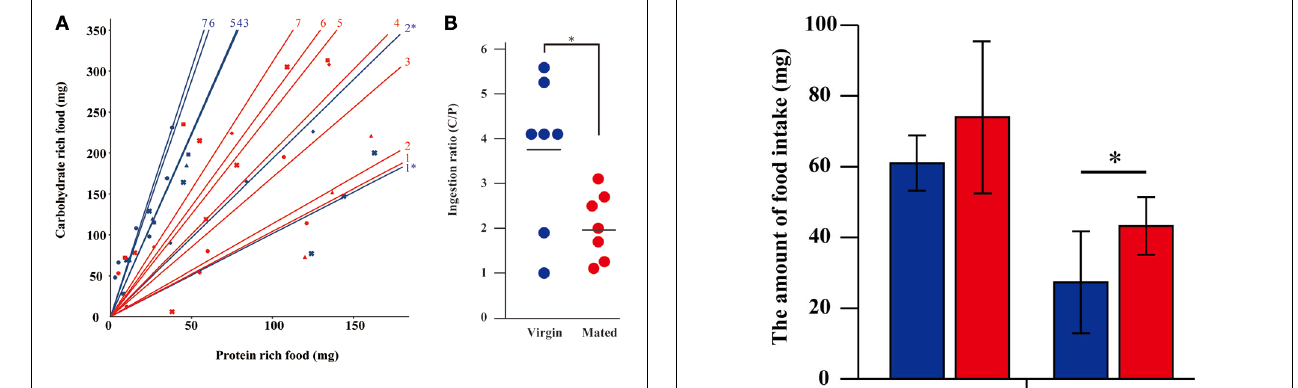
FIGURE 3 | The transition of dietary preference after mating. (A) The geometric framework analysis by mated female crickets. The horizontal axis represents the amount of protein-rich food intake and the vertical axis represents the amount of carbohydrate-rich food intake using “generic” diet tablets. Red and blue spots indicate the measured values from mated and virgin females, respectively. Different symbols indicate different individuals. Red and blue approximate lines indicate mated and virgin females, respectively. Data were plotted as every day. The same symbol indicates the points of the amount of food ingested each day individual. Each data point was plotted as an accumulated value from the first observation day in this figure. The numbers of individuals examined are indicated. An asterisk represents the data from an unusual cricket as described in the text. (B) The ingestion ratio of “generic” casein-rich diet/protein-rich diet (C/P) by mated and virgin females. Dots indicate the data from individual crickets. Bars indicate mean values. Data were statistically analyzed by Student’s t- test. P- values less than 0.05 were considered to be statistically significant. ∗ P < 0 . 05. N = 7, Mean ± SD .